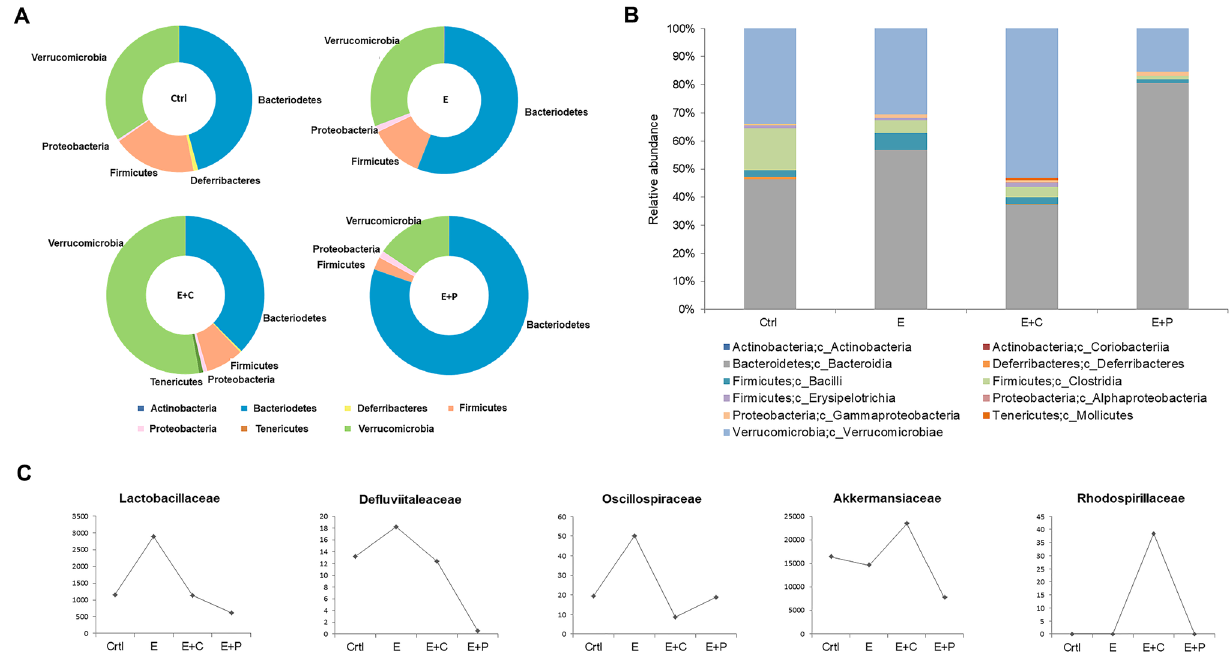
Figure 3. High-fiber diet changes the gut microbiota composition. Taxonomic plots showing the relative abundance across the different groups. ( A , B ) Phylum- ( A ) and class- ( B ) level relative abundance of the fecal microbiome of each group. ( C ) Family level bacteria-specific relative compositional changes in all groups. (n = 5 mice per group). Ctrl control group, E emphysema group, E + C emphysema with high-cellulose diet group, E + P emphysema with high-pectin diet